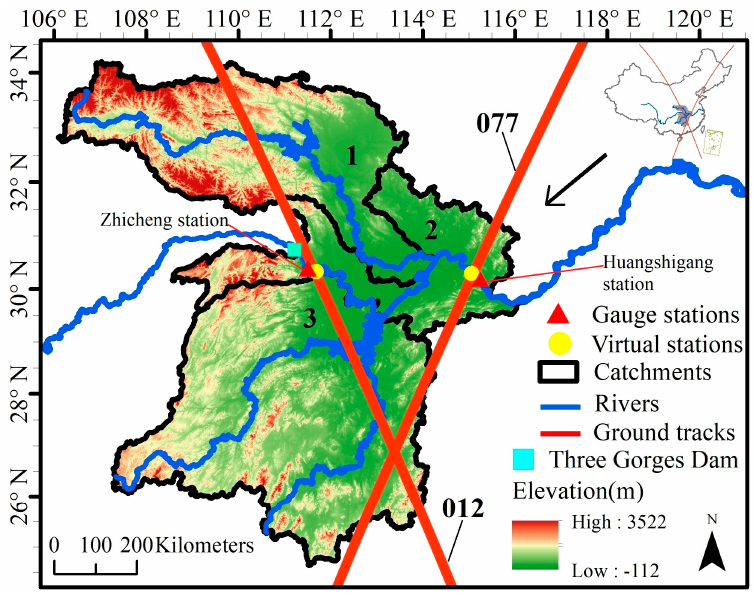
Figure 1. Location of the Zhicheng–Huangshigang reach of the Yangtze River (ZHY) Basin and the ground track 012 and 077 of Jason-2/3 satellites.